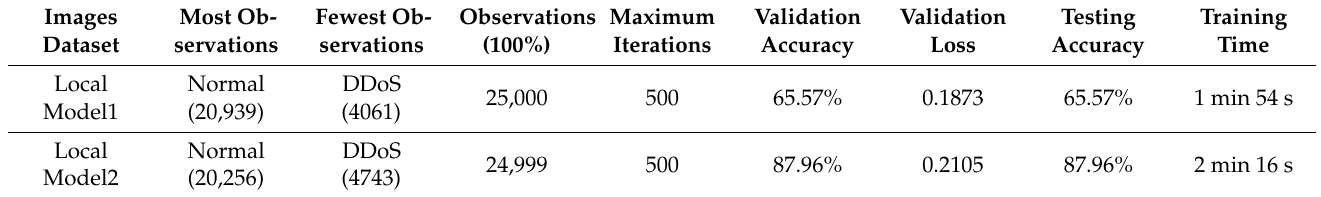
Table 4. Experimental results of training progress using the FL method and the 12-layer